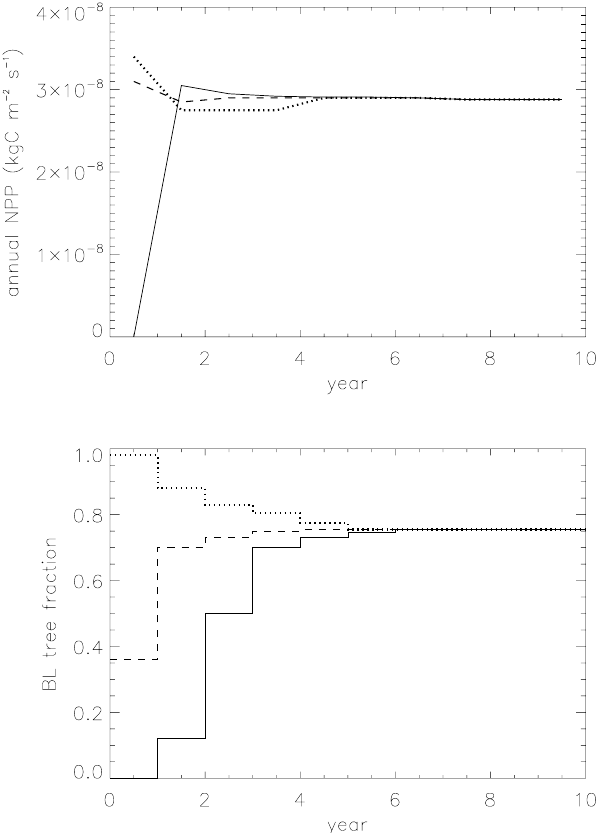
Fig. 3. An example of the spin up of TRIFFID in equilibrium mode. The lines show evolution from different initial conditions with con- vergence after five calls to TRIFFID. (Top) NPP (Bottom) the frac- tional coverage of the broadleaf tree